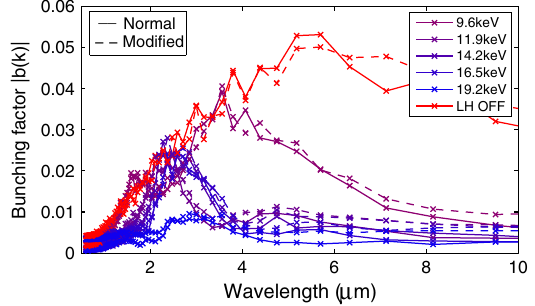
FIG. 12. A comparison of the bunching results at 0.5 kA using normal bunching factor (solid lines) and modified bunching factor (dashed lines).